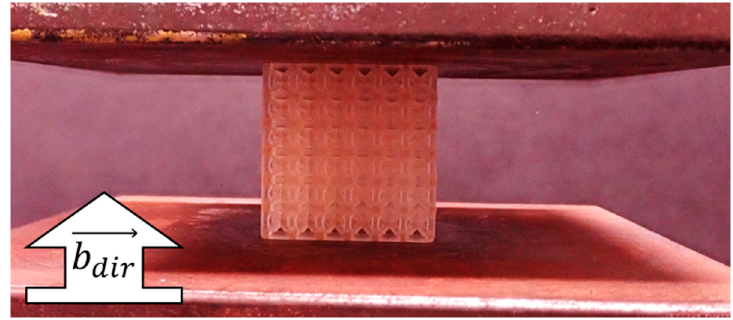
Figure 4. Mechanical testing for lattice compression.